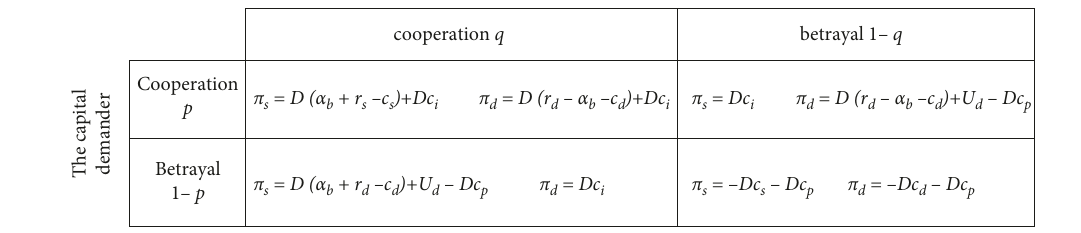
Figure 4: Payoff matrix of game participants of blockchain financing warehouse. Table 4: Optimal response strategy of game participants of blockchain financing warehouse.